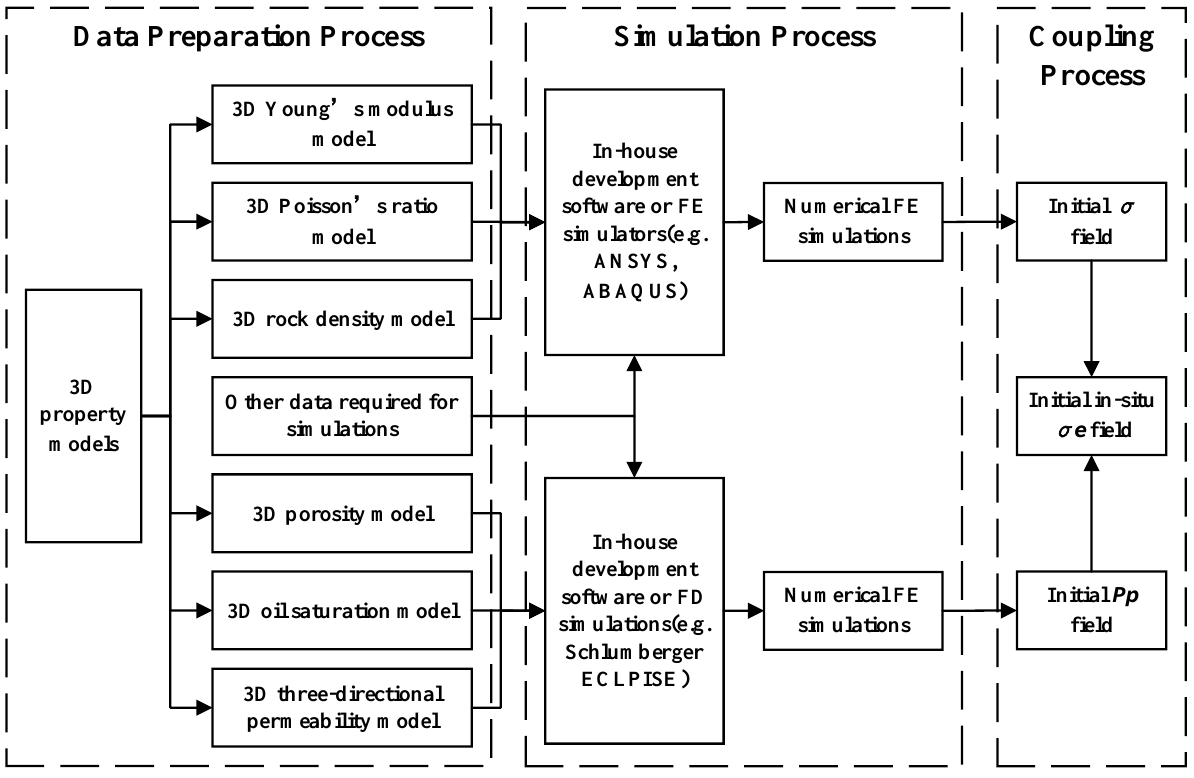
Figure 1. Method for modeling an initial σ e field through reservoir – geomechanics coupling.